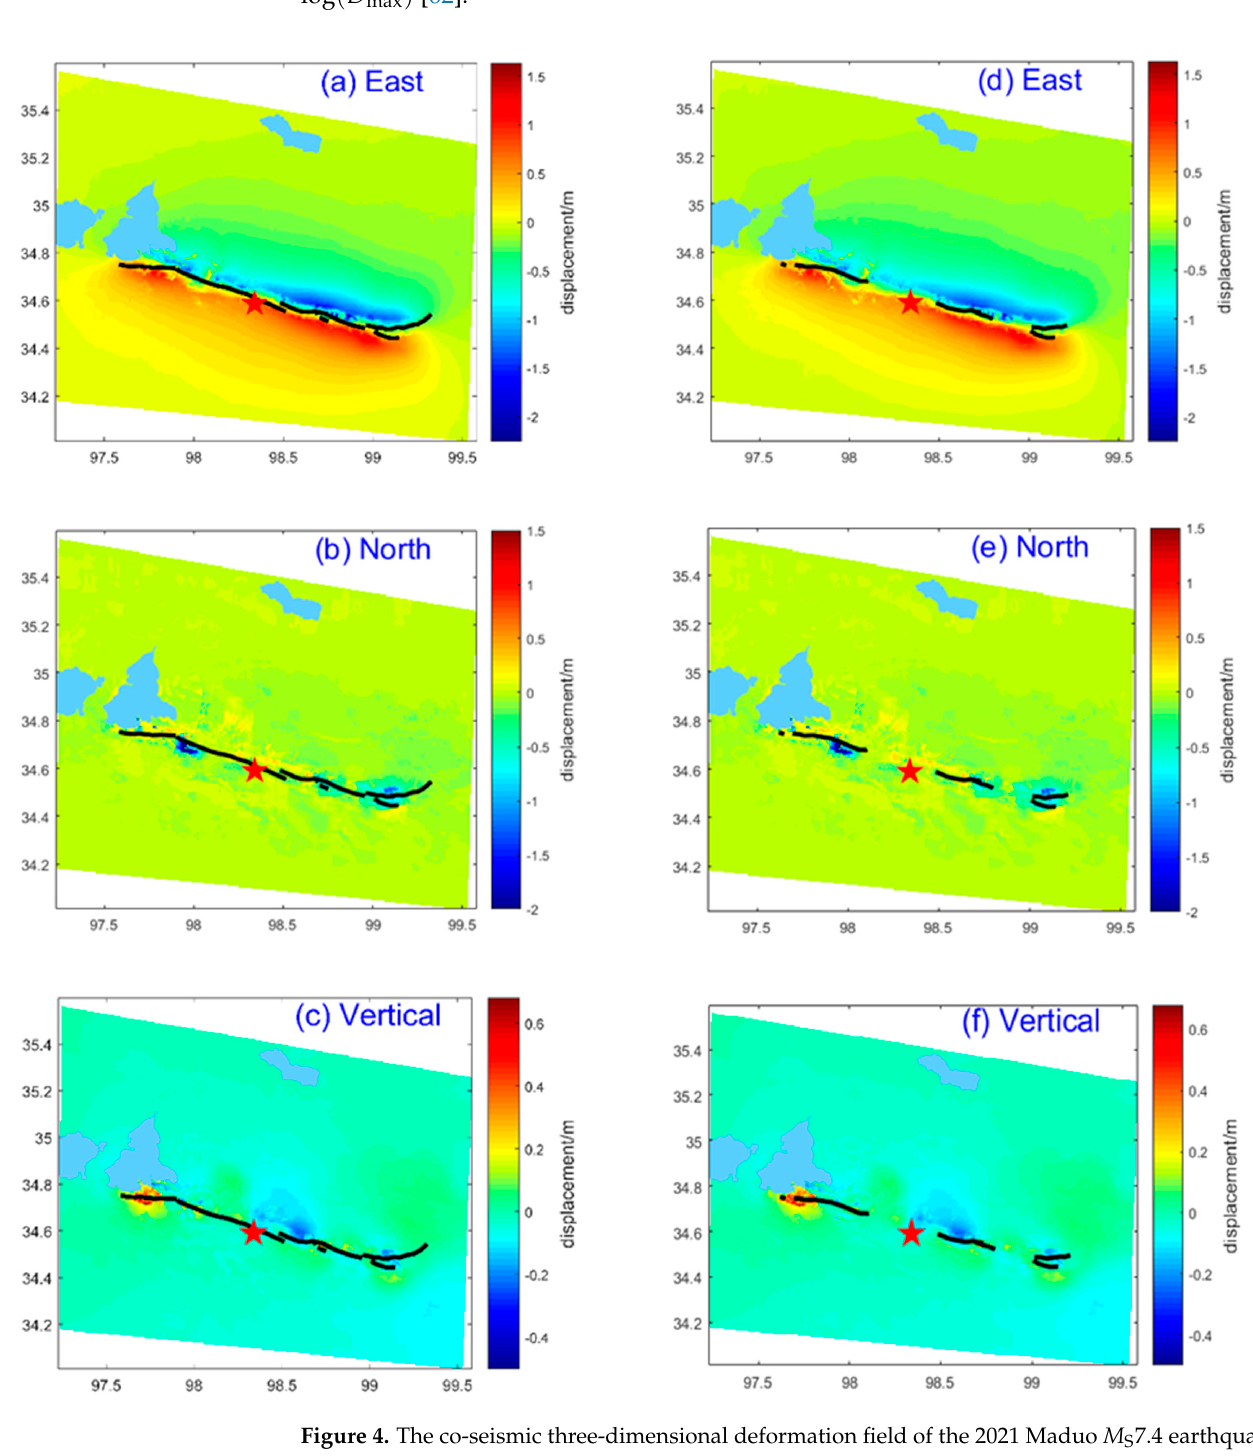
west deformation was dominant in the earthquake fault deformation. We considered that the east–west component result could indicate the earthquake fault movement mode. As shown in Figure 4, when the displacement was decomposed into three components, the displacement was large in the east–west direction with a wide range (See Figure 4a,d), and obvious left-lateral shear stress happened on both sides of the fault (the displacement to the west in the north of the earthquake fault, the displacement to the east in the south of the earthquake fault), which indicated that it was a typical left-lateral strike-slip earth- quake. The deformations at both ends of the main surface rupture far away from the